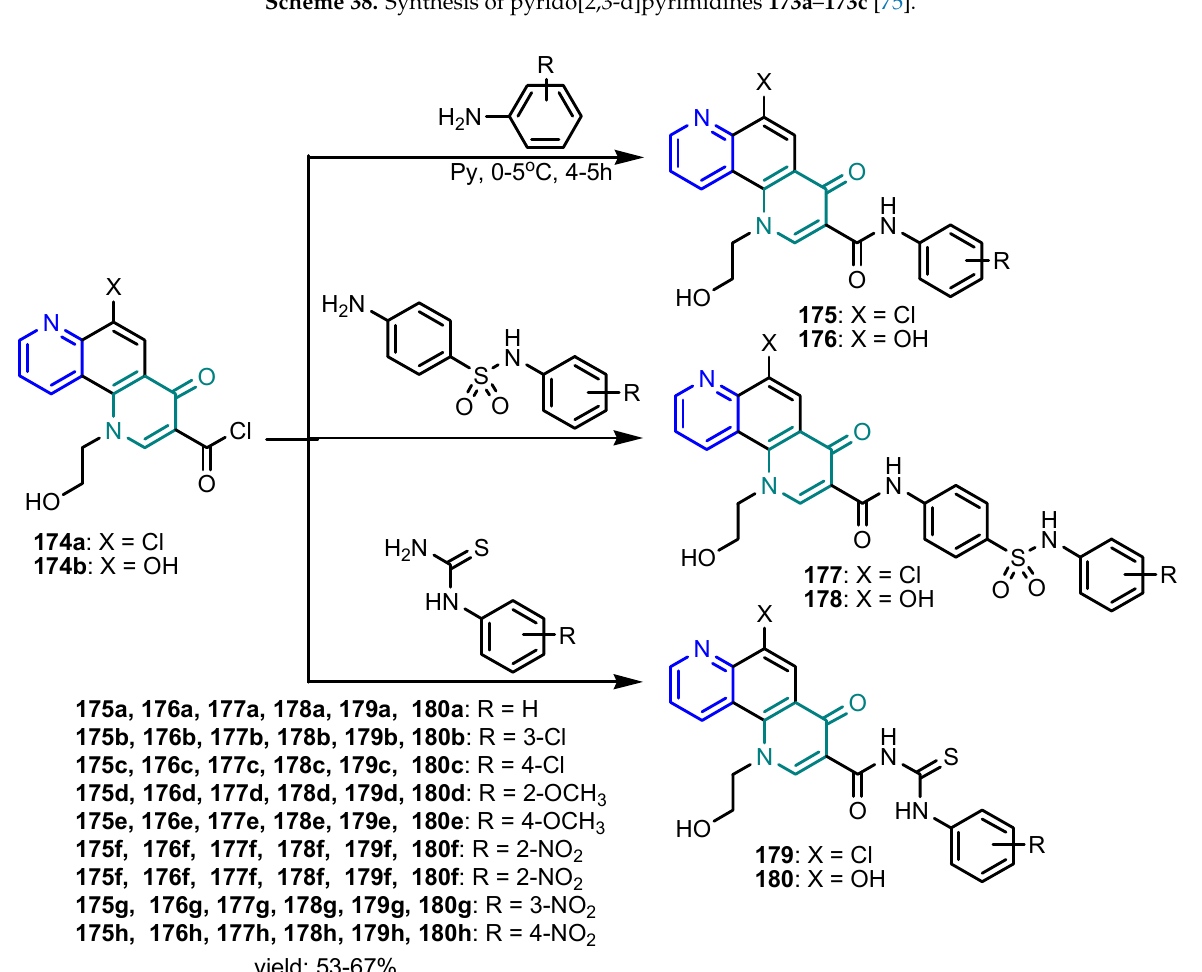
Scheme 39. Synthesis of pyridoquinolone 175 – 180